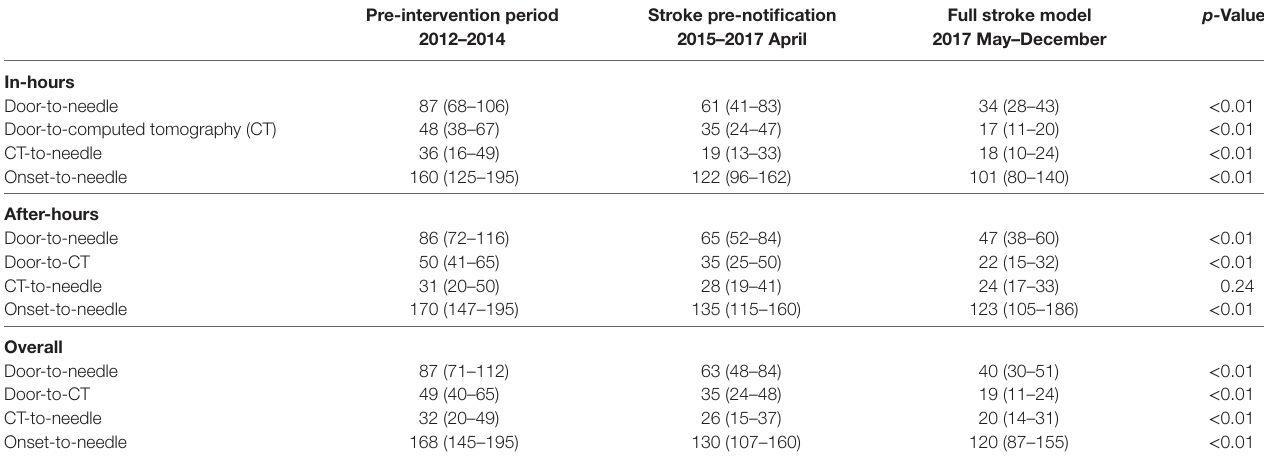
TaBle 3 | Summary of different time metrics represented in minutes [median (interquartile range)] for thrombolysed patients at Christchurch Hospital.